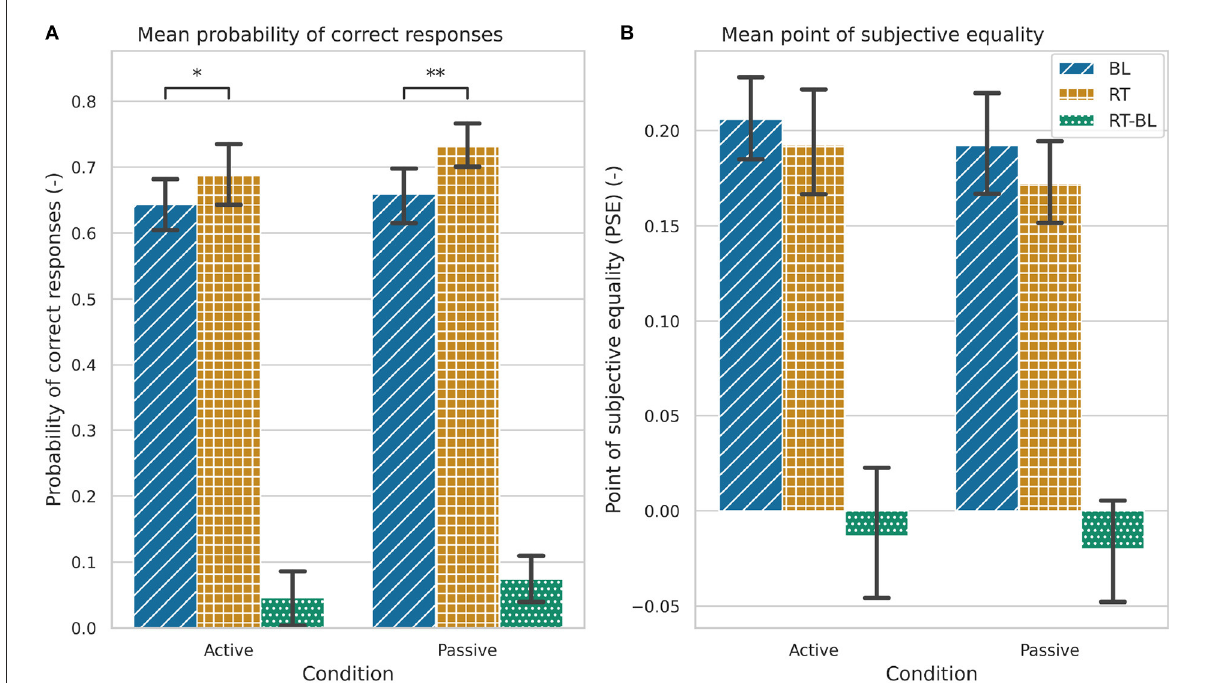
FIGURE9 Task performance during baseline (BL), retention (RT), and the changes between baseline and retention (RT-BL) for the active and passive conditions. (A) Probability of correct responses. (B) Point of subjective equality (PSE). Statistically significant differences are marked by ( ∗ p < 0.05) , ( ∗ ∗ p < 0.001) . The error bars represent the confidence intervals.